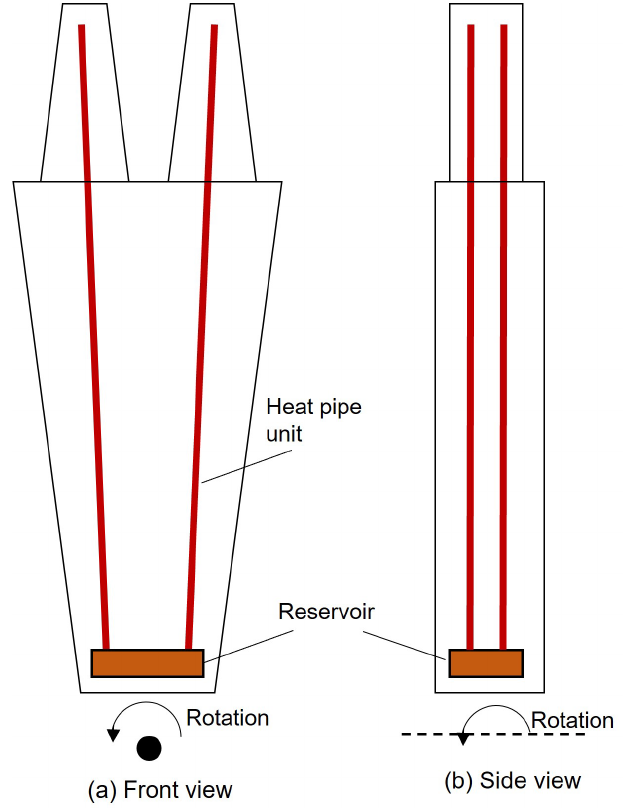
Figure 4. Schematic illustration of the RRHP designed by Cao et al. [40].